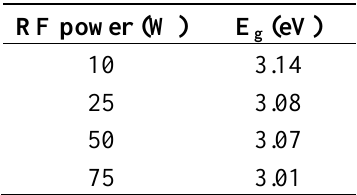
Table 2. Optical bandgap of pp–GT thin films for m = 3/2.